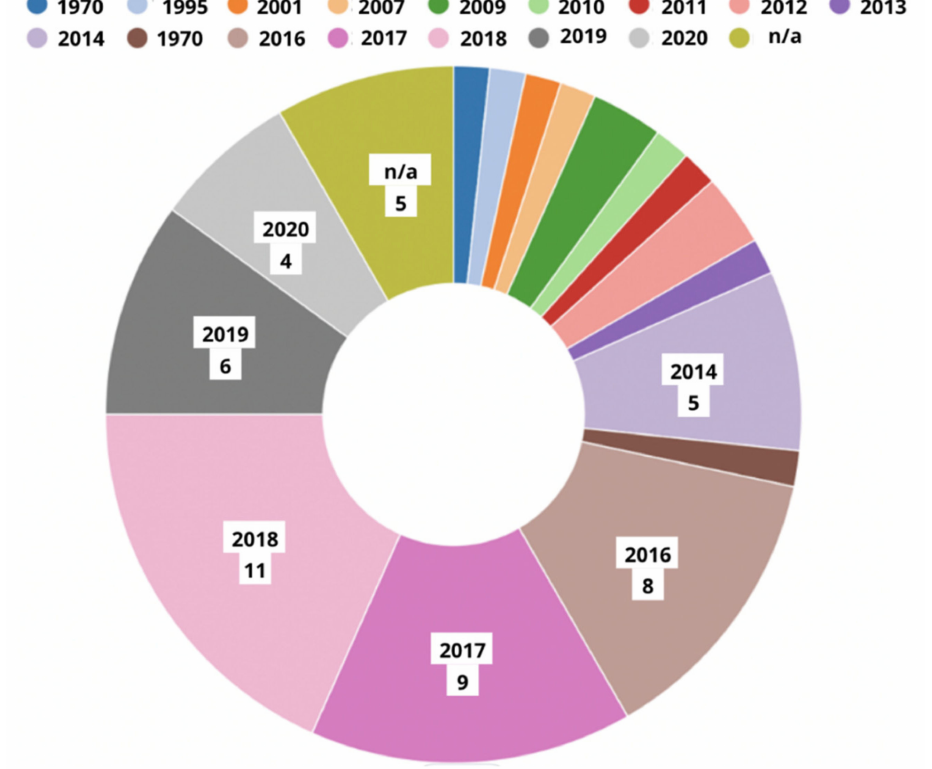
Figure 1. Initiated year of PED related